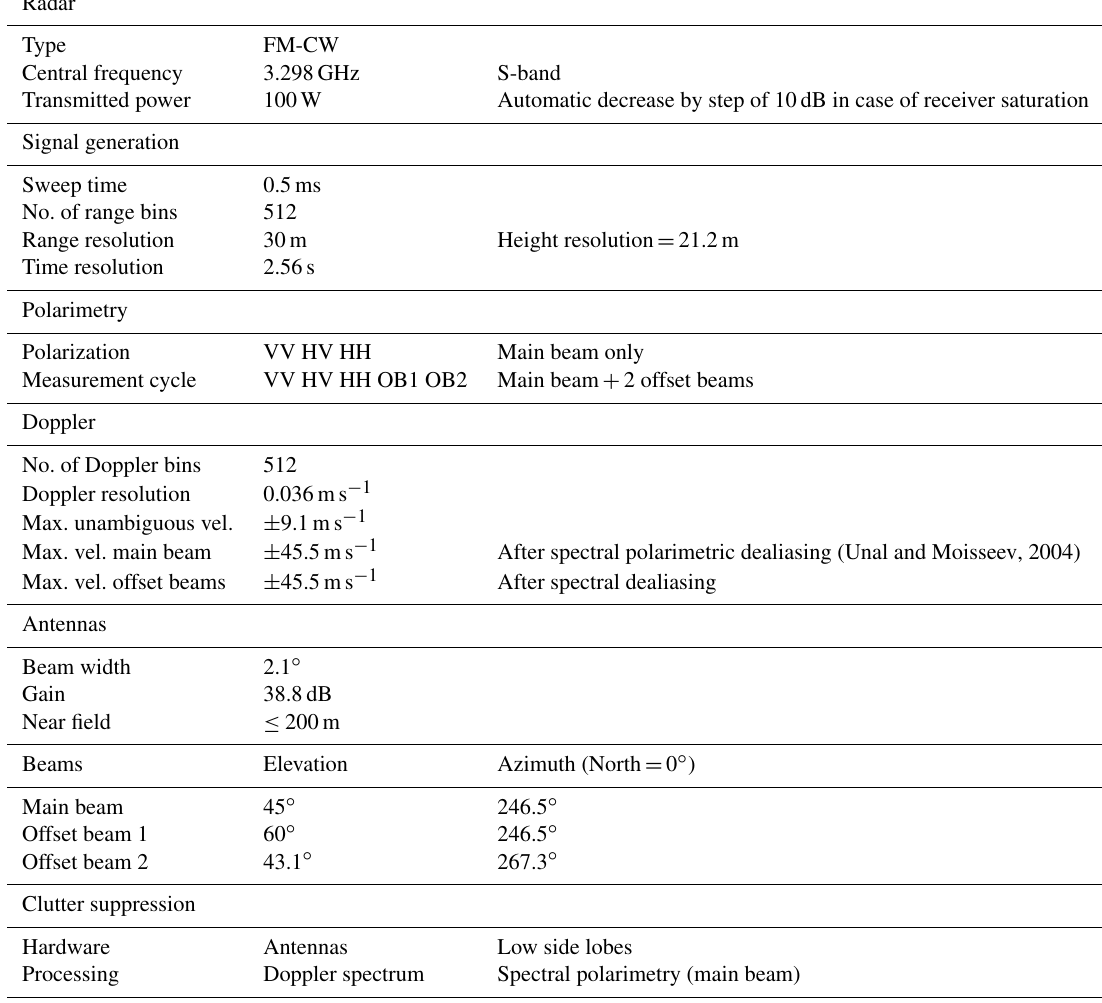
Table 1. Specifications of the TARA radar during the ACCEPT